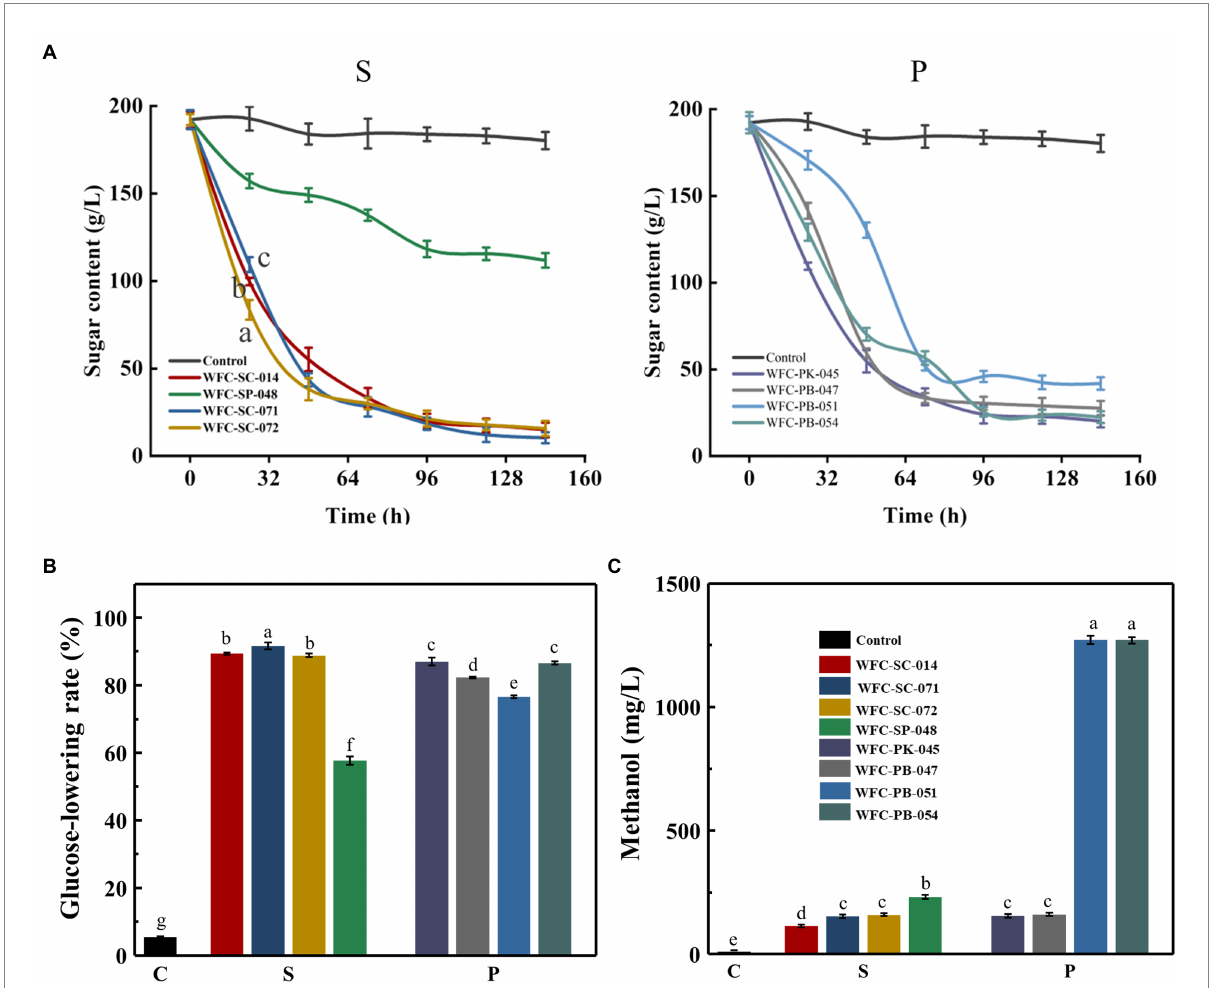
FIGURE 2 Growth capability of isolated strains on apple juice. (A) Total sugar consumption by Saccharomyces cerevisiae strains and Schizosaccharomyces pombe strain (S), and Pichia yeasts (P). (B) Glucose-lowering rate of apple juice fermented by different strains for 7 days. Means within glucose- lowering rate between different yeasts with different letters (a–g) differ significantly ( p < 0.05). Both sugar consumption and glucose-lowering rate experiments were replicated three times. (C) Methanol concentration in ciders fermented by eight yeasts. Means with different letters (a–e) differ significantly ( p < 0.05). Most strains had robust growth capability and produced acceptable amounts of